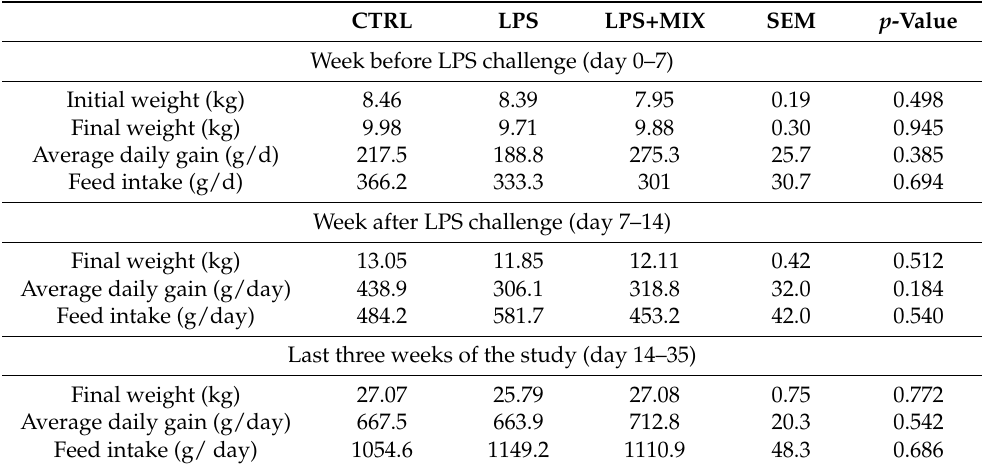
Table 2. Weekly performance of the piglets included in the study.